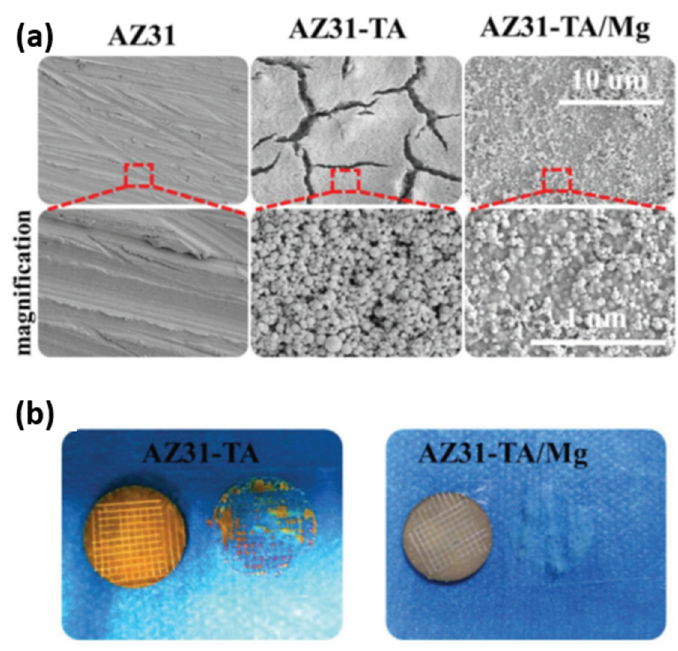
Figure 17 . Surface morphology of AZ31, AZ31-TA, and AZ31-TA/Mg. ( a ) SEM morphologies, ( b ) tape test on AZ31-TA and AZ31-TA/Mg using Scotch tape. Adapted and reprinted from [328] with permission from John Wiley & Sons.